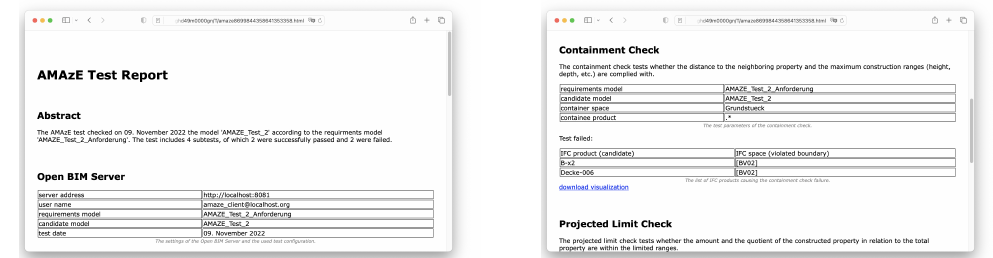
Figure 11. The output of the application has the same structure as used in the application itself (see Figure 10). The first part comprehends a summary of the server, the requirements model and the candidate model ( left ). The second part provides information on the tests, especially in case of a failure to report the names of the entities which did not pass the approval test ( right